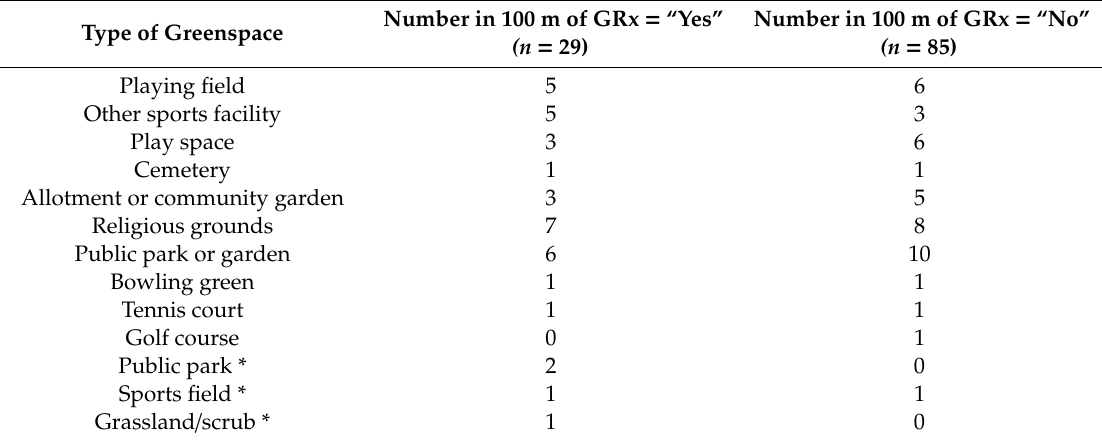
Table 1. A list of greenspace type within a 100 m bu ff er radius of GPs that do and do not prescribe GRx. Type of